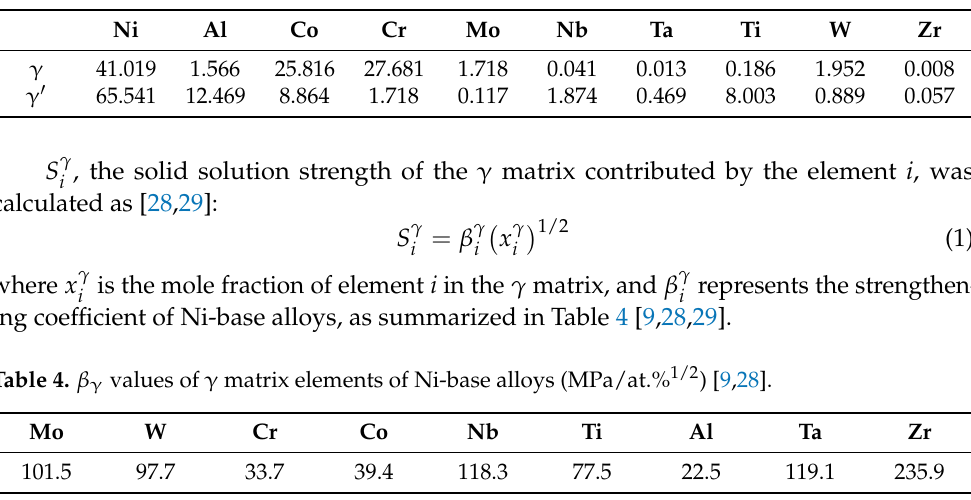
Table 3. The equilibrium compositions in at.% for the γ matrix and γ (cid:48) phase at 760 ◦ C in FGH4107, as calculated in JMatPro 6.0.